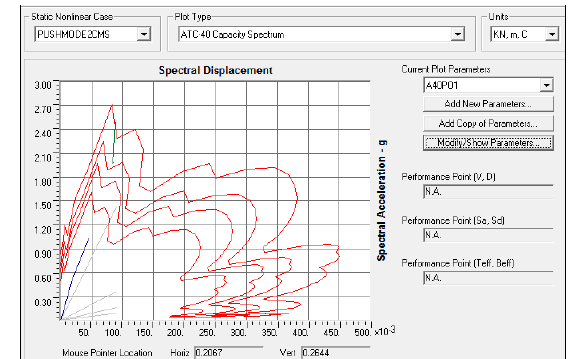
Fig. 14. Capacity spectrum in the longitudinal direction for El Centro earthquake Table 4. Structural ductility of Koyembedu Bridge in transverse and longitudinal direction Earthquake Transverse direction El